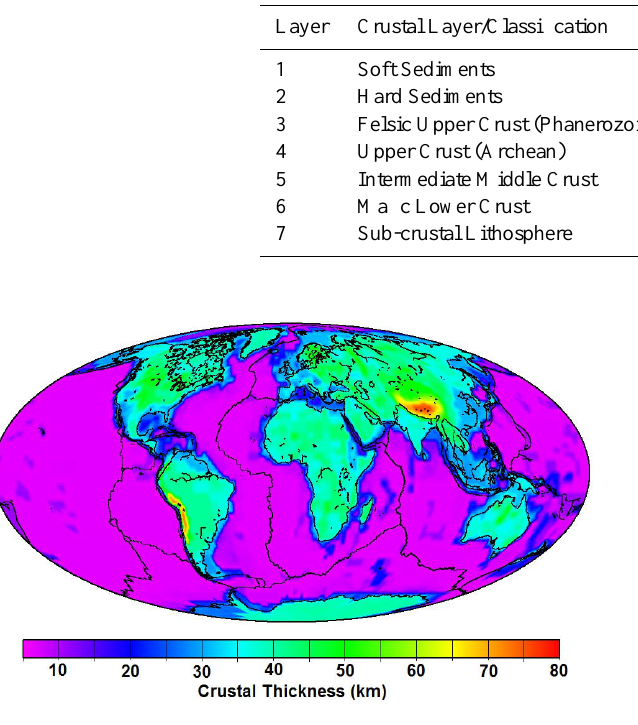
Fig. 5. Global distributions of the thickness of the continental crust, derived using the data base of Mooney et al. (1998).